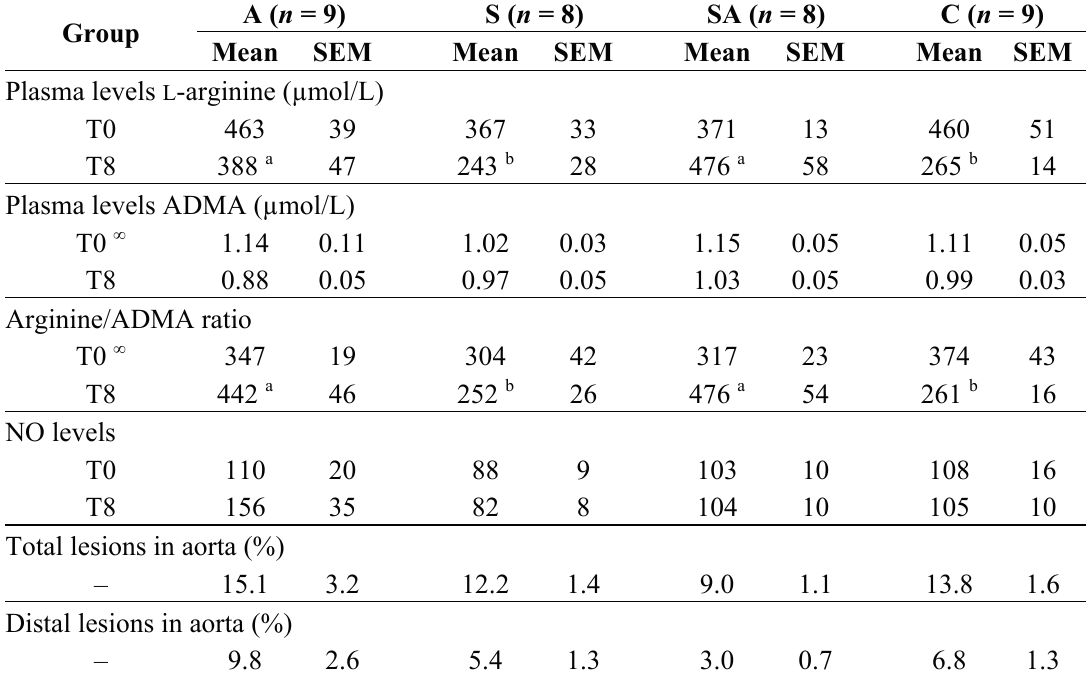
Table 1. Effect of different treatments on arginine levels, ADMA levels, arginine/ADMA ratio, and atherosclerotic lesions in the